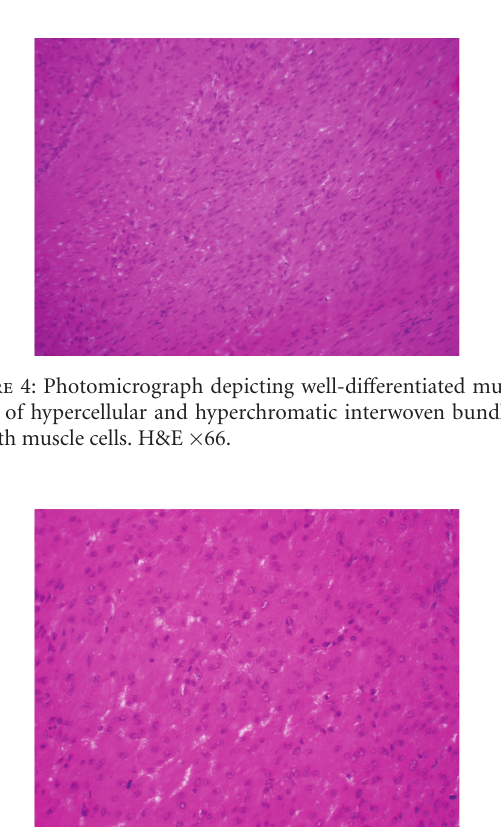
Figure 5: Photomicrograph from an area of tumor showing marked increase in its cellularity and occasional mitotic elements. H&E ×